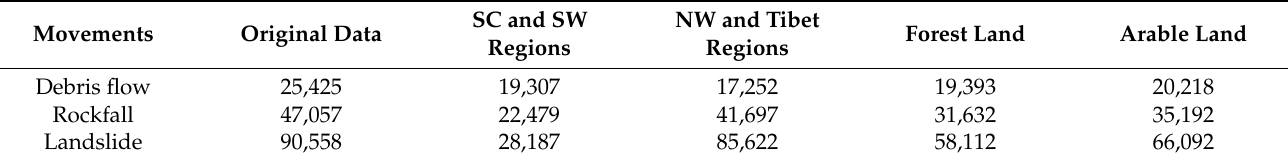
Table 5. The number of mass movements in different highly biased inventories.